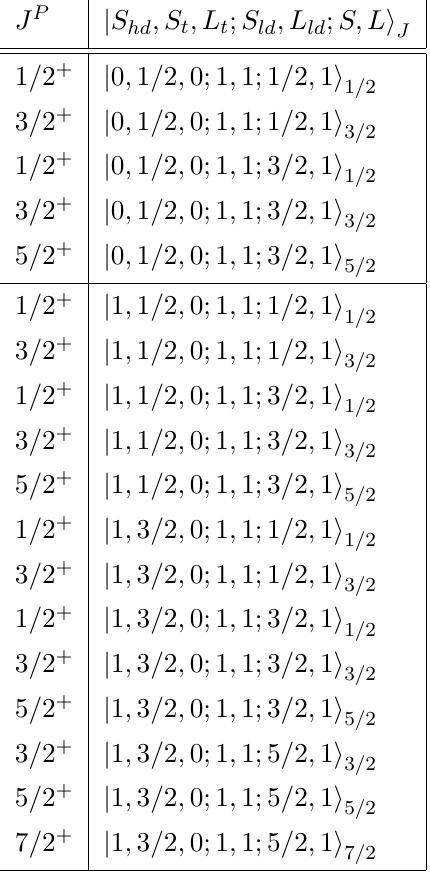
Table 4 . Spin-parity J P and state vectors of the P -wave pentaquarks with the ground- state triquark ( L t = 0) and \good" light di- quark with the spin S ld = 0. The horizontal line demarcates the spin S hd of the heavy di- quark.